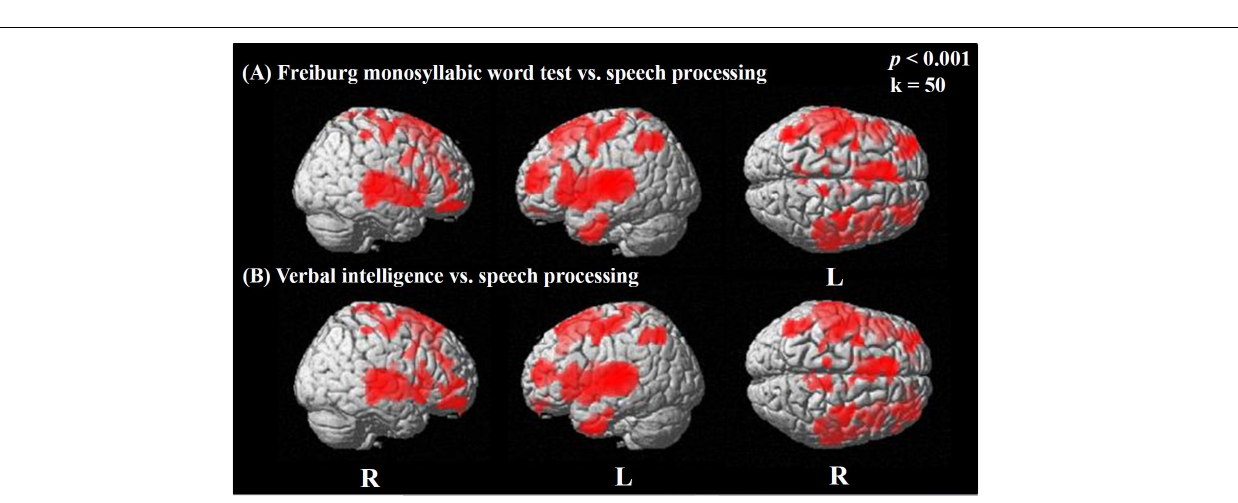
FIGURE 4 | Statistical parametric maps (SPMs) reflecting relative differences in baseline perfusion between groups of cochlear-implant (CI) users with higher and lower performance in speech comprehension according to the GÖSA test (median-split procedure). SPMs are overlaid to a surface rendered MRI data set in the Montreal Neurological Institute (MNI) space. There are some areas displayed more transparent than others, which refers to their distance to the projection surface. Note a pattern of higher baseline perfusion in right parietal areas and motor cortex in CI users with lower performance compared to higher performers (A) , while a pattern of higher baseline perfusion in hippocampal and inferior frontal areas is seen in higher as compared to lower CI performers (B) .